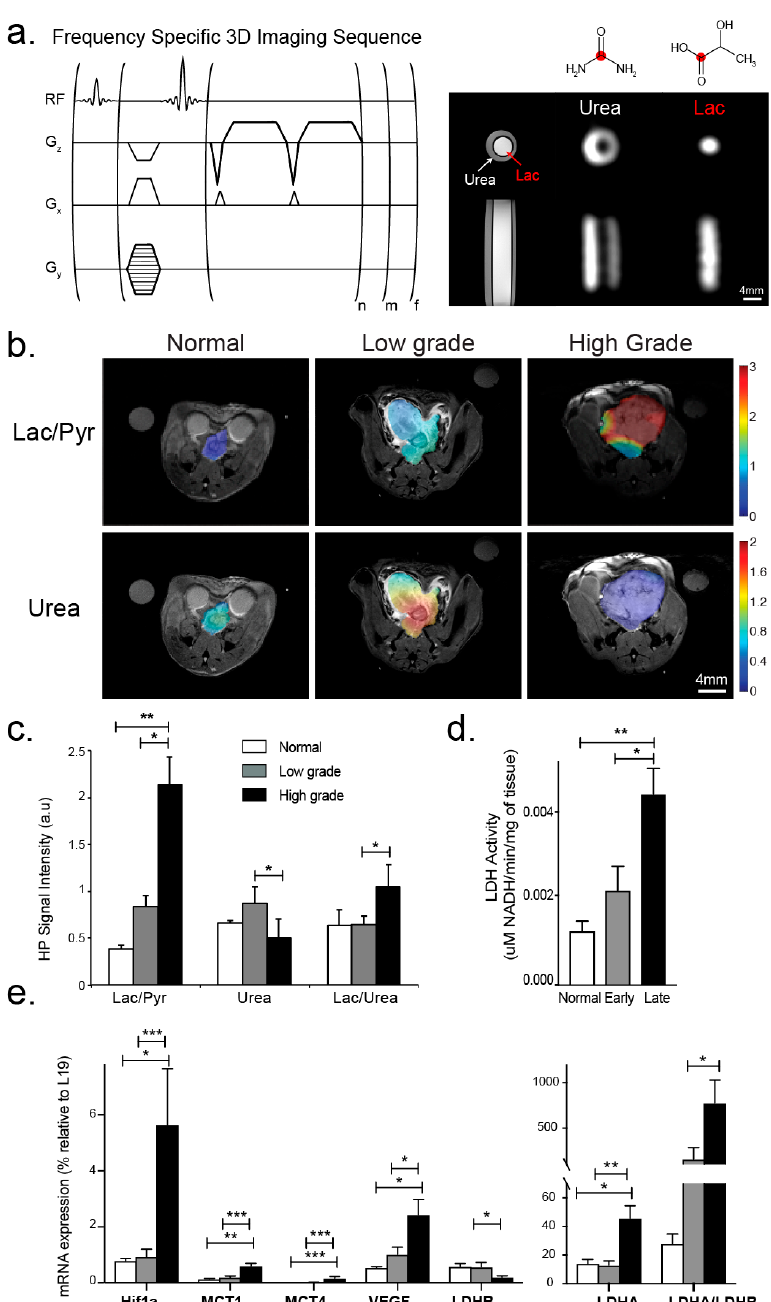
Figure 4. ( a ) (top, left) Pulse sequence diagram of the high-spatial resolution 3D GRASE HP 13 C MRSI imaging approach used for in vivo HP 13 C imaging in this study (n and m number of phase encodes and f is the number of frequencies). ( a ) (top, right) Resonances of [1- 13 C] lactate, [1- 13 C] alanine [1- 13 C] pyruvate, and [ 13 C] urea were excited and imaged sequentially as shown for the 13 C lactate and 13 C urea phantom. ( b ) Representative HP 13 C Lac/Pyr and 13 C-urea images overlaid on the corresponding T 2 -weighted anatomic images for the normal prostate, and low- and high-grade cancer. The color scale of the images represents the magnitude of the Lac/Pyr ratio. ( c ) Bar graph showing mean ± sdev values for Lac/Pyr, Urea/kidney Urea and Lac/Urea ratio from the normal mouse prostates and low and grade tumors studied. ( d ) Corresponding mean ± sdev LDH activity values. ( e ) Corresponding mean ± sdev mRNA expression values of key transporters and enzymes associated with pyruvate and lactate transport and metabolism ( Mct1 and Mct4 , Ldha and Ldhb ) and of factors impacted by the hypoxic tumor microenvironment ( Hif1 α and Vegf ). * denotes p < 0.05, ** for p < 0.005, *** for p < 0.0005.